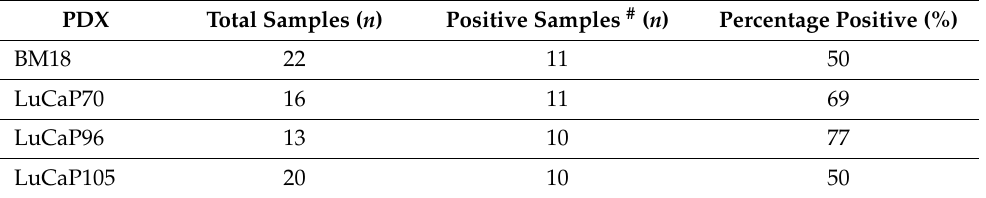
Table 2. Summary of proportion of positive samples for each PDX model.